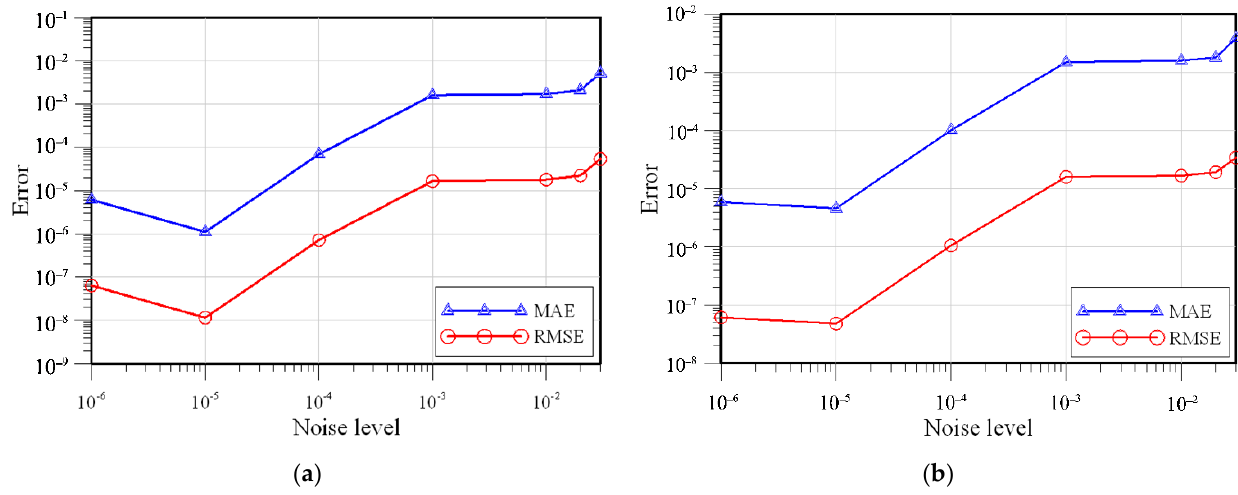
Figure 14. Error versus the noise level: ( a ) case A. ( b ) case B.